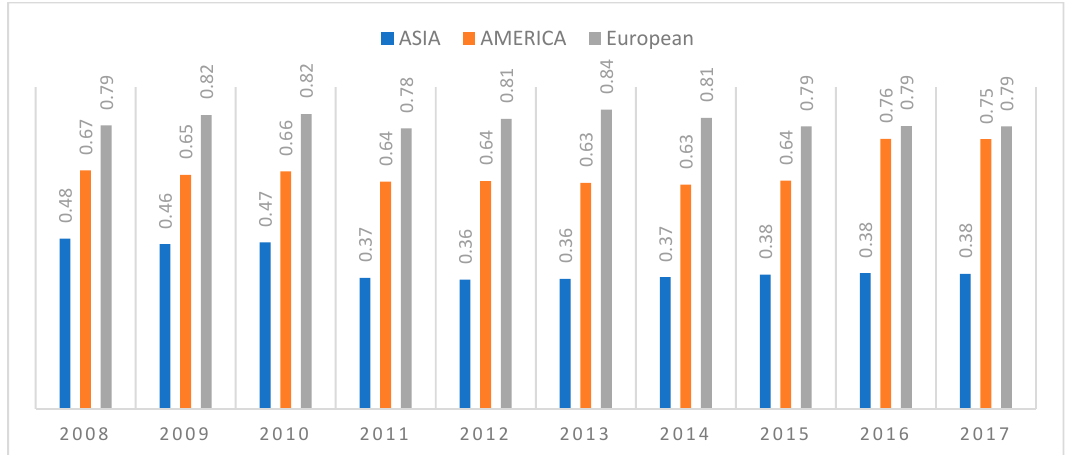
Figure 3. Energy efficiency of Europe, the Americas, and Asia from 2008 to 2017.